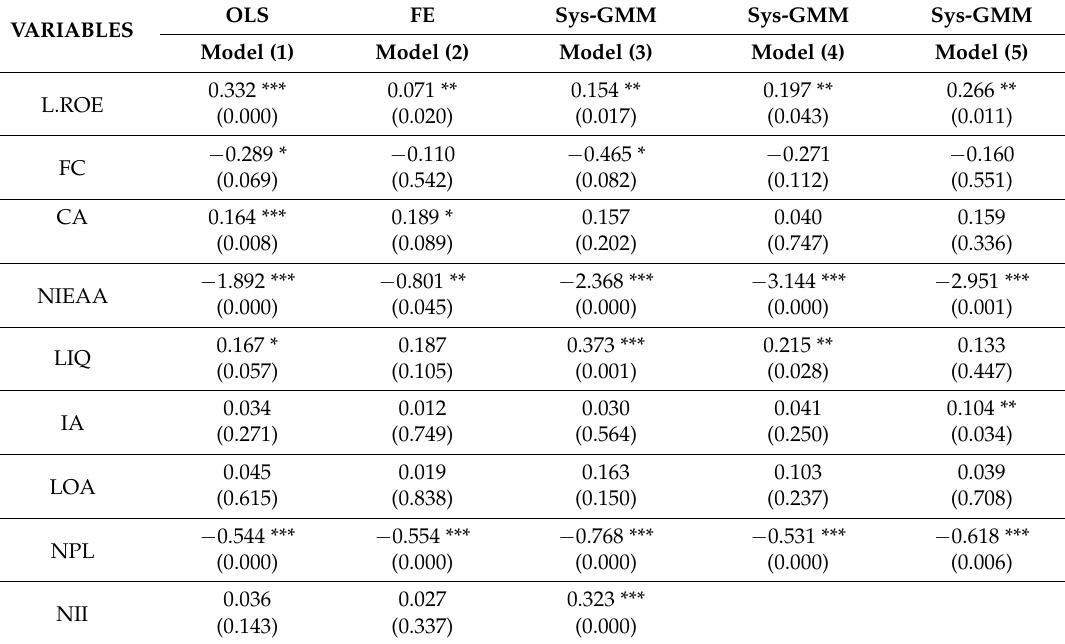
Table 7. Results for alternative measure of bank profitability ROE as dependent